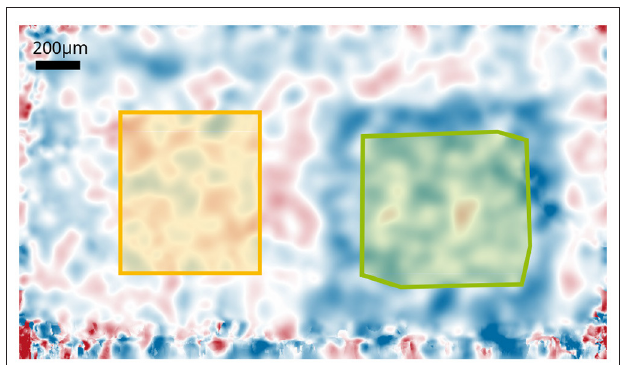
FIGURE 4 | Phase changes of the central layer of the IPL after 8s stimulation with 12.5Hz. Areas used for the background corrections are indicated. The green marked area is the mask for the functional changes that is used to extract the time courses; the yellow marked area corresponds to the mask used to obtain the background